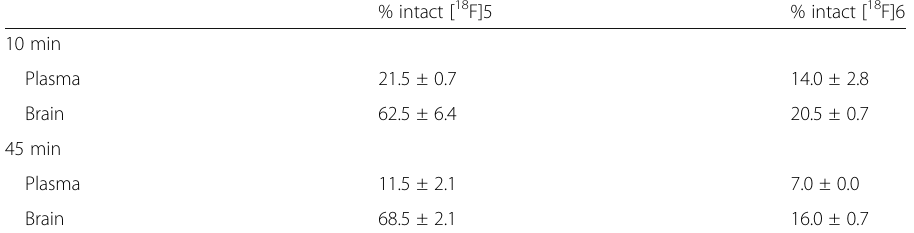
Table 3 Percentage of intact tracer in plasma and brain after 10 and 45 min ( N = 2)